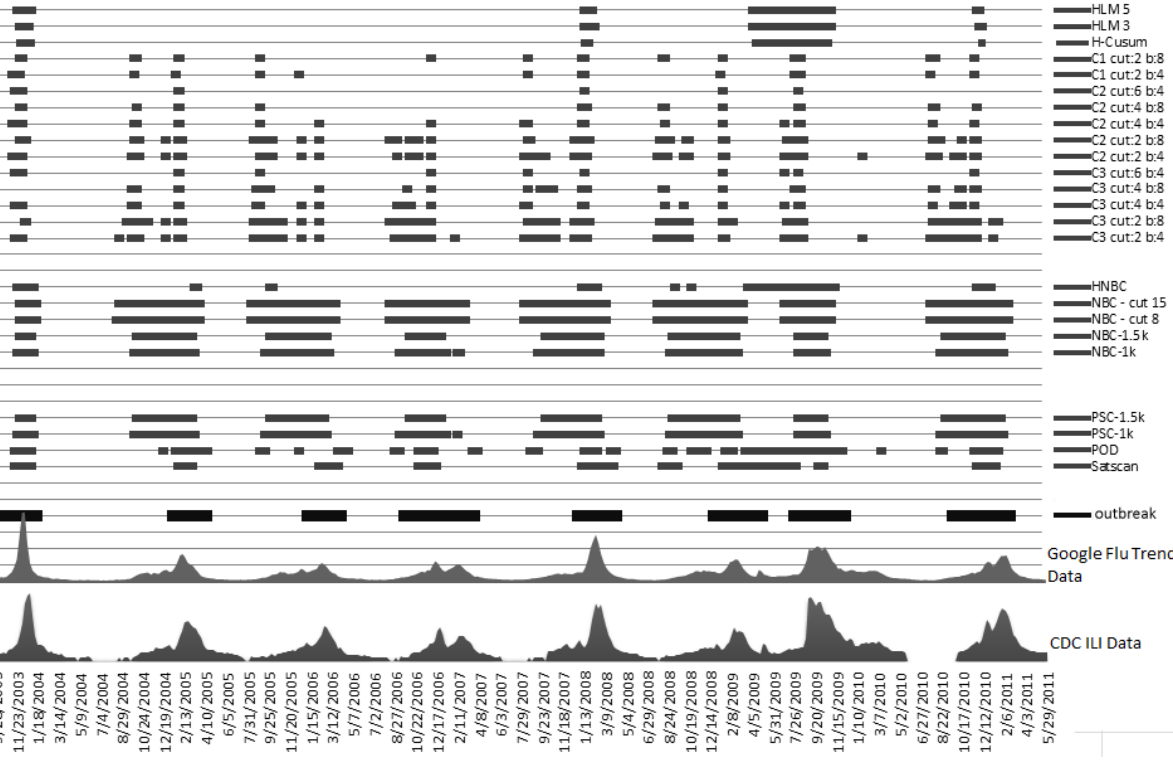
Figure 10. US Department of Health and Human Services region 4. The x-axis plots the Google Flu Trends and Centers for Disease Control and Prevention (CDC) data. The horizontal bars indicate where each method detected an epidemic. Cut indicates the cut-off point (more is less sensitive) and b indicates baseline data (training window). The thick horizontal bars at the bottom show the actual outbreak. HCusum = historical cumulative sum, HLM = historical limits method, HNBC = historical negative binomial cumulative sum, ILI = influenza-like illnesses, k = reference value for threshold, NBC = negative binomial cumulative sum, POD = Poisson outbreak detection, PSC = Poisson cumulative